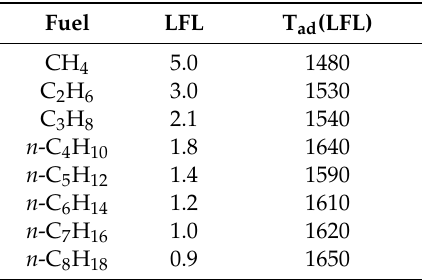
Table 8. The calculated adiabatic flame temperature at flammability limit for hydrocarbon type fuels. Reproduced from Ref. [102], Gordon and Breach Science Publishers, Inc.: